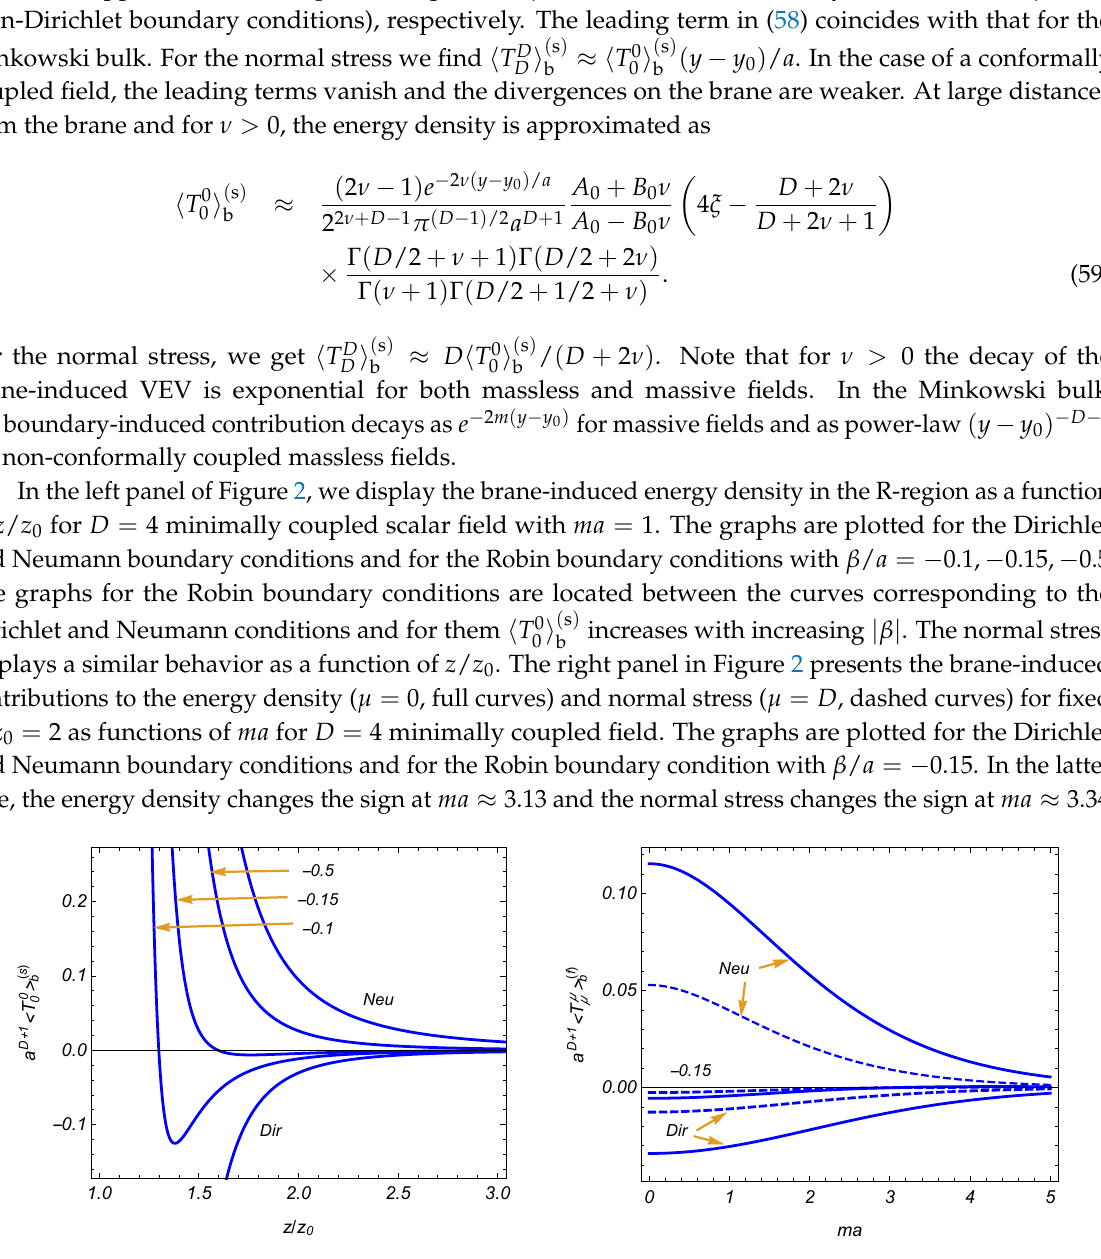
Figure 2. The brane-induced contributions in the VEVs of the energy density and the normal stress for D = 4 minimally coupled scalar field and for: ( left ) ma = 1; and ( right ) z / z 0 = 2. The full and dashed curves on the right panel correspond to the energy density and normal stress, respectively (for the boundary conditions chosen, see the